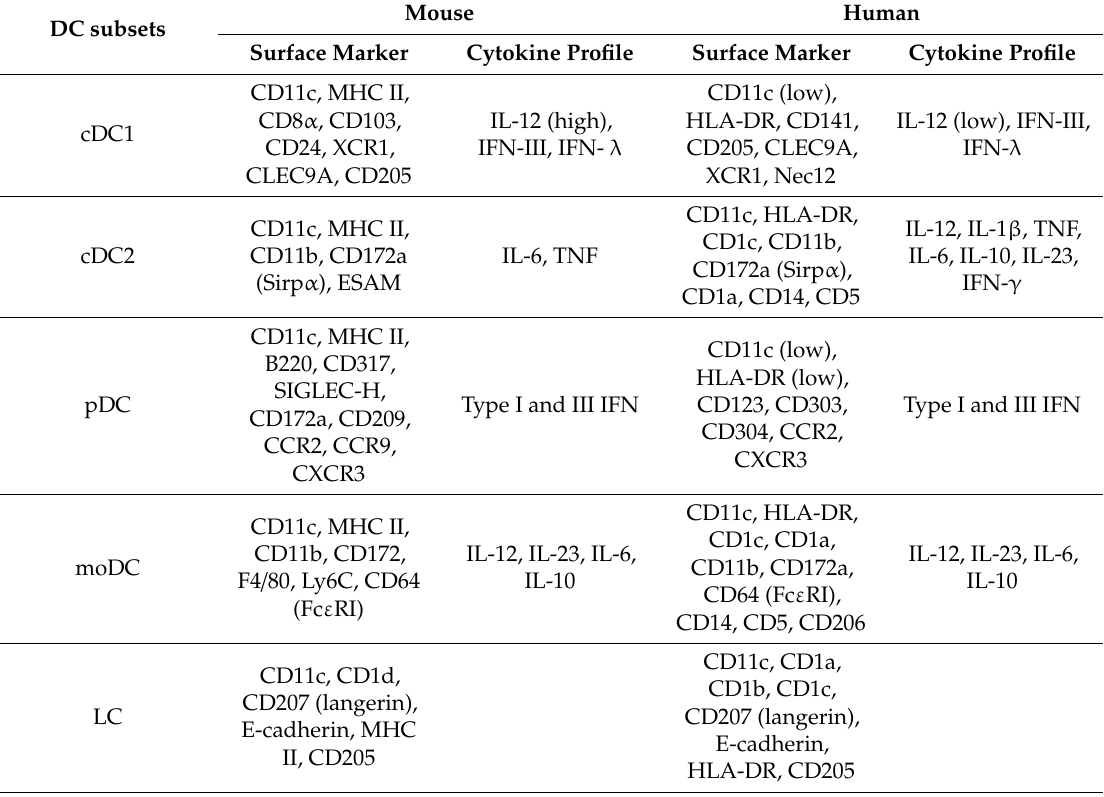
Table 1. Major dendritic cell (DC) subsets and surface markers